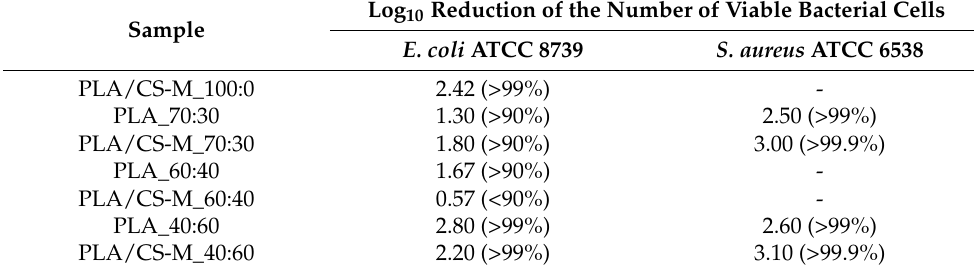
Table 6. Log 10 reduction of Escherichia coli ATCC 8739 and Staphylococcus aureus ATCC 6538 in contact tests with PLA-based biocomposites.